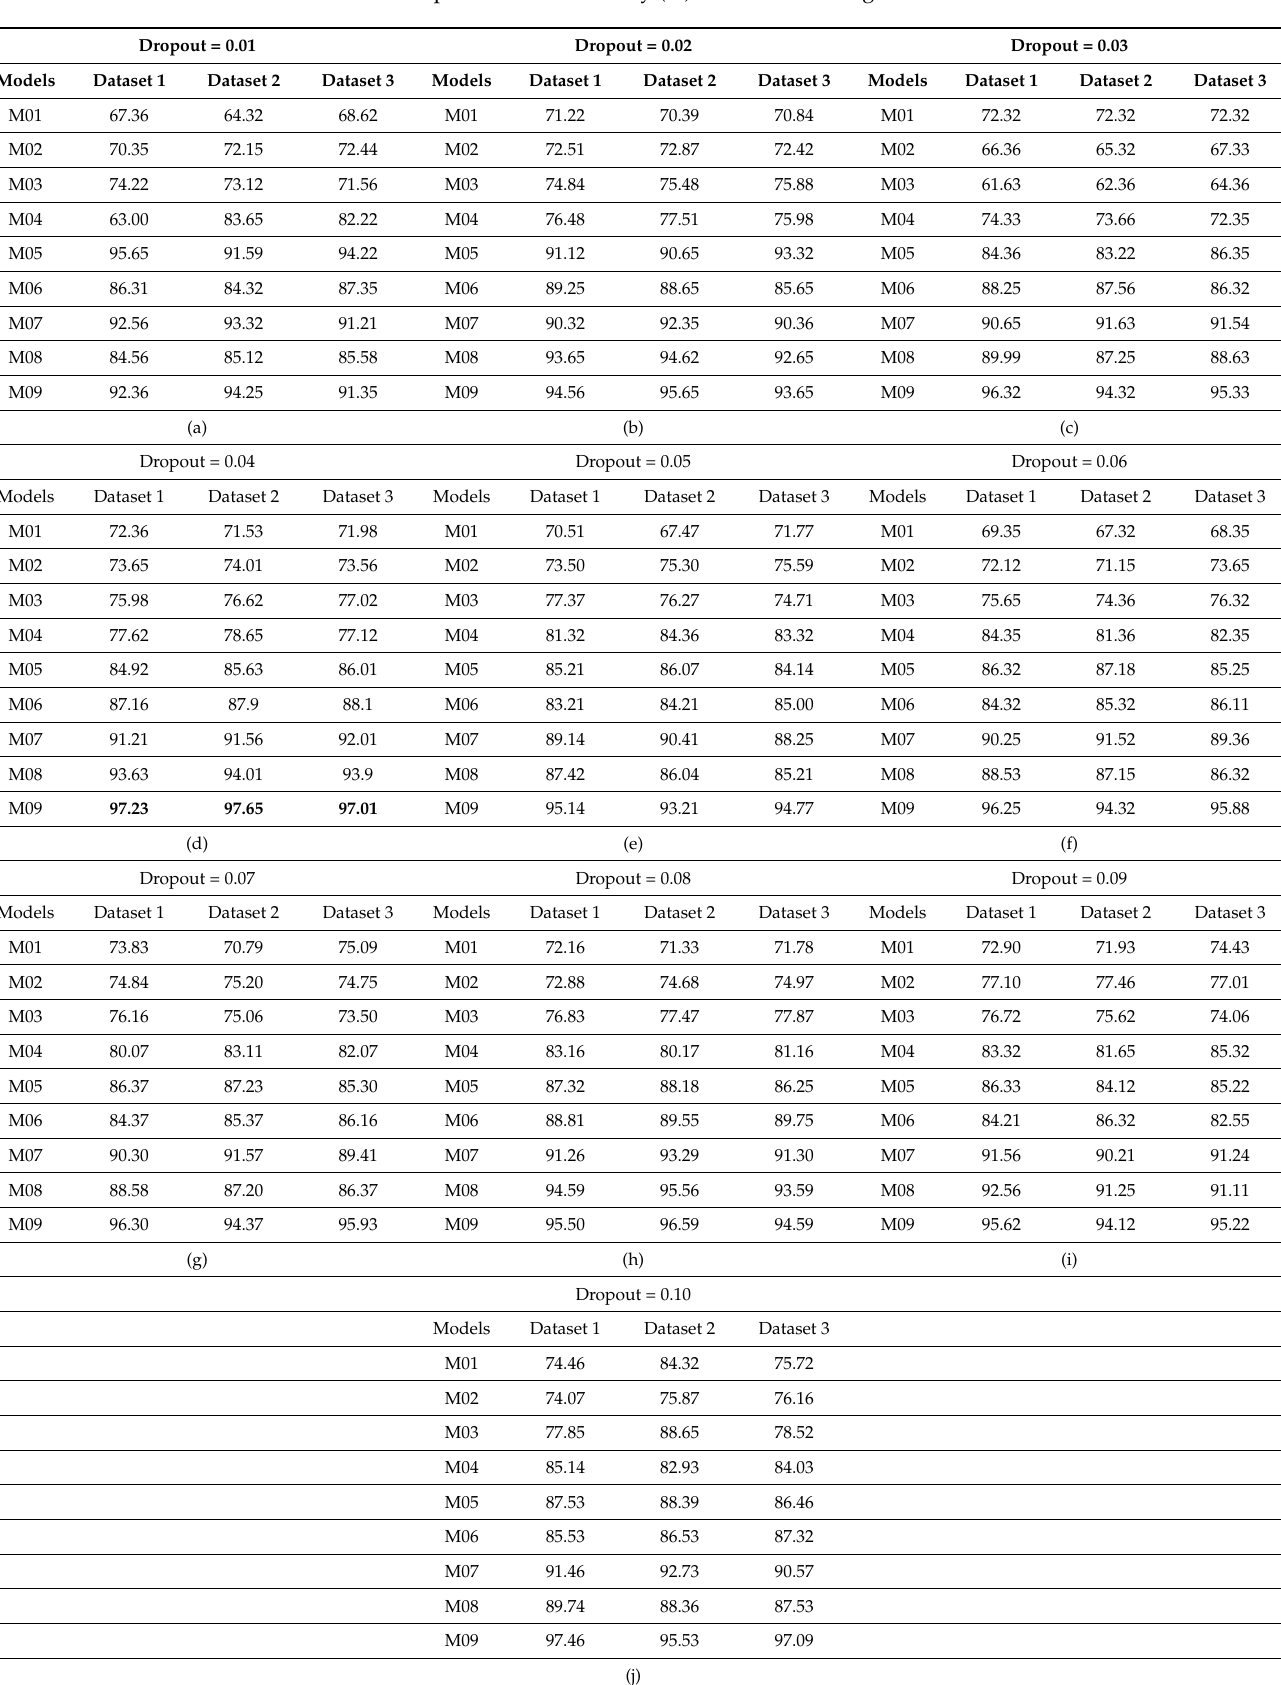
Table 6. The performance accuracy (%) for an embedding size of